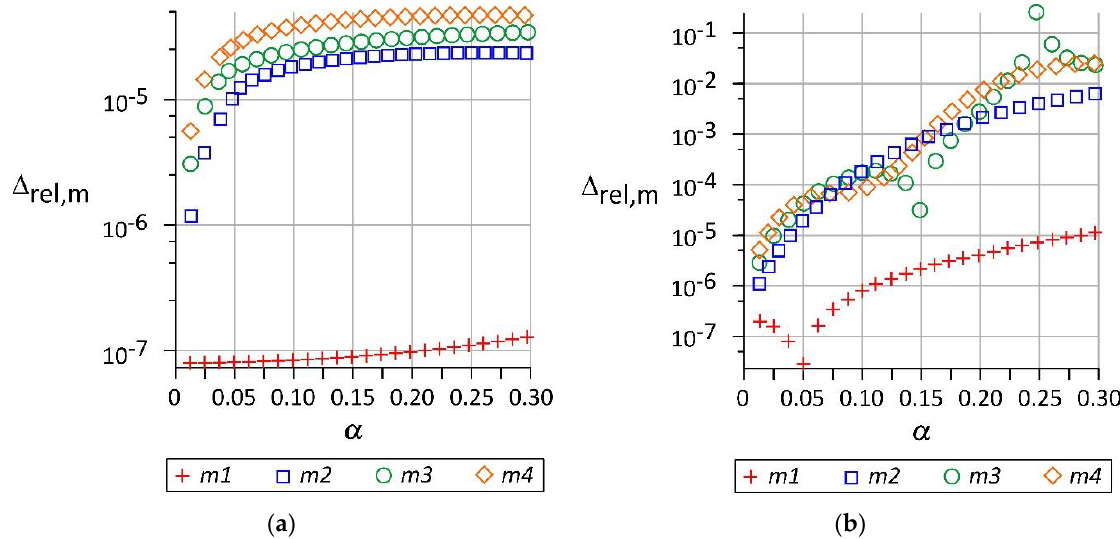
Figure 6. The relative error of the probabilistic moments Δ rel,m for the input coefficient of variation on the example of two approximations: ( a ) approximation with the function y 4 based on the polynomial of POa = 1 of the discrete data generated by the function y 4 with POb = 1 and poly = 1, ( b ) approximation with the function y 11 based on the polynomial of POa = 2 of the discrete data generated by the function y 11 with POb = 2 and poly = 1.